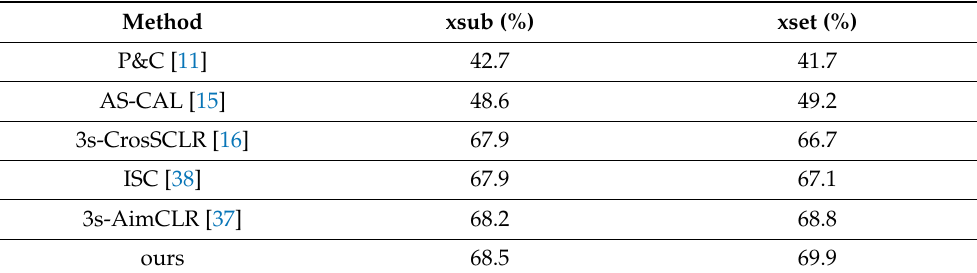
Table 5. Linear evaluation results on NTU-120